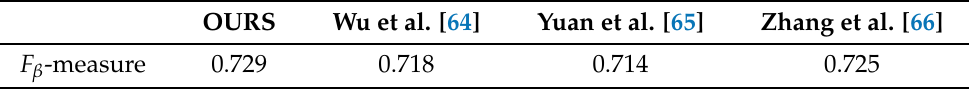
Table 6. Our model’s F β -measure results compared with some of the recent models for the EC- SSD dataset.